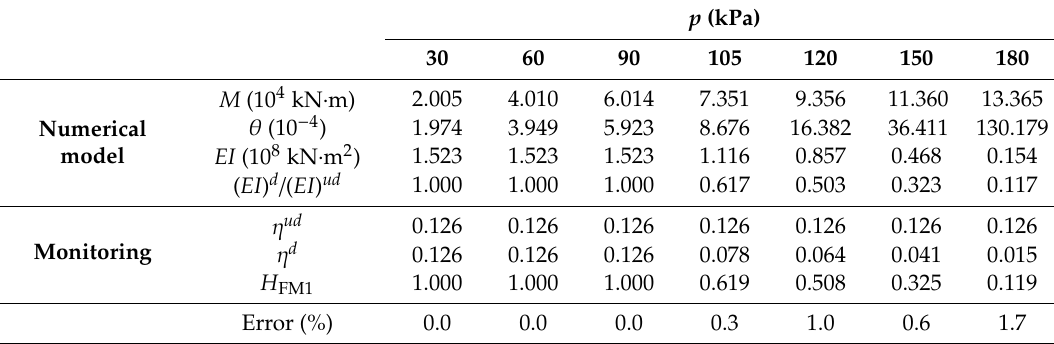
Table 7. Comparison between ( EI ) d / ( EI ) ud and H FM1 in E9.